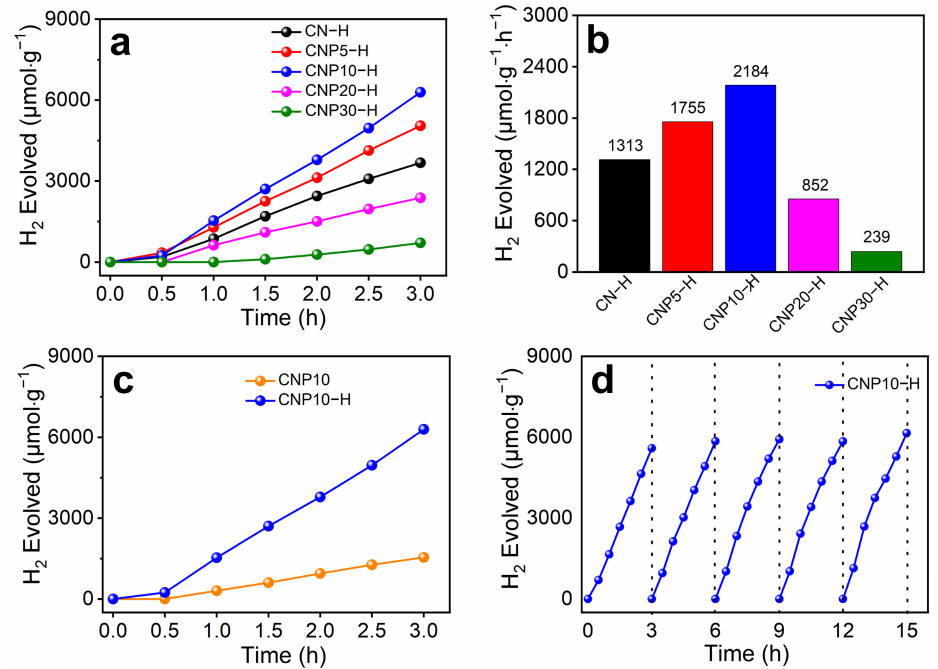
Figure 4. ( a ) Time-dependent photocatalytic H 2 production of the samples; ( b ) photocatalytic H 2 evolution rates of CNPx-H; ( c ) time-dependent photocatalytic H 2 production of CNP10 and CNP10-H; ( d ) photocatalytic-stability test for H 2 production of CNP10-H under visible-light ( λ > 420 nm) irradiation using TEOA as the sacrificial agents and Pt as cocatalyst.